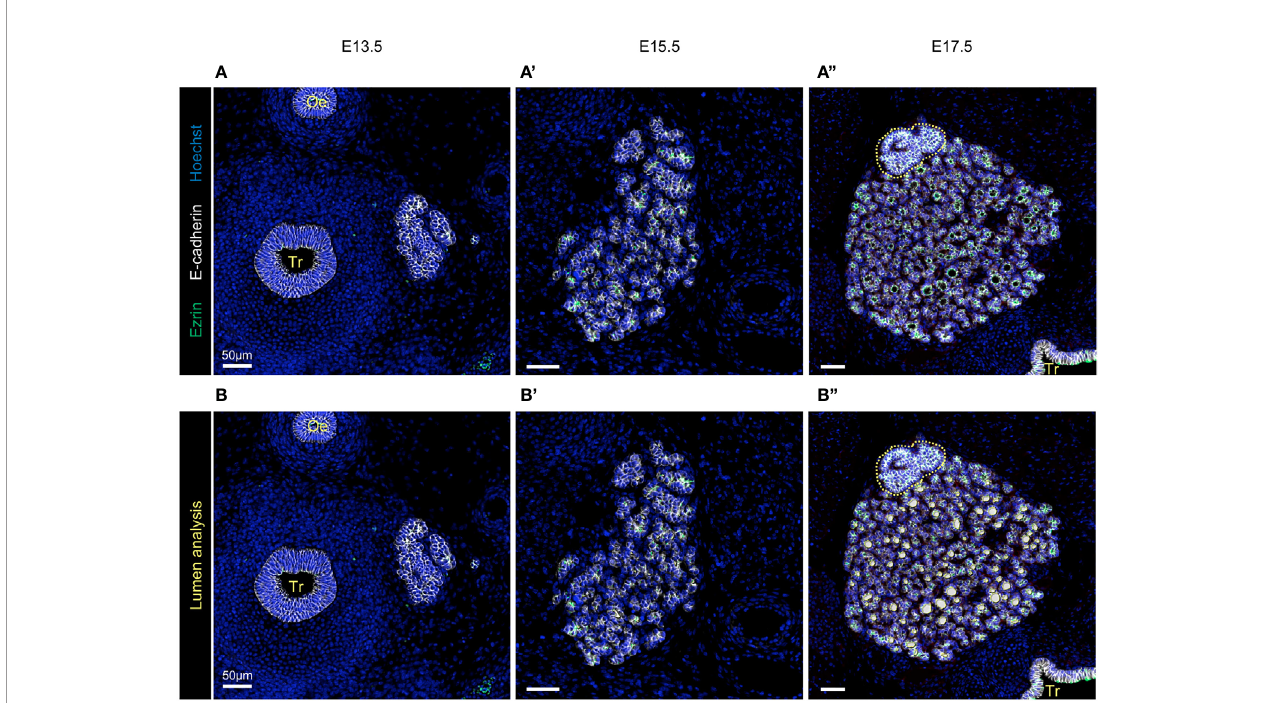
FIGURE 6 | Visualisation and quanti fi cation of lumen formation in developing thyroid at three different embryonic stages. (A – A ’’ ) Immunolabelling of epithelial cells in white (E-cadherin) and apical pole of epithelial cells in green (Ezrin). Nuclei are stained in blue (Hoechst). Tr, trachea; Oe, oesophagus. (B – B ’’ ) Epithelial lumen within the analysed region of interest (in grey) were coloured in yellow using HALO (mostly visible in B ’ and B ’’ ) and superimposed on the